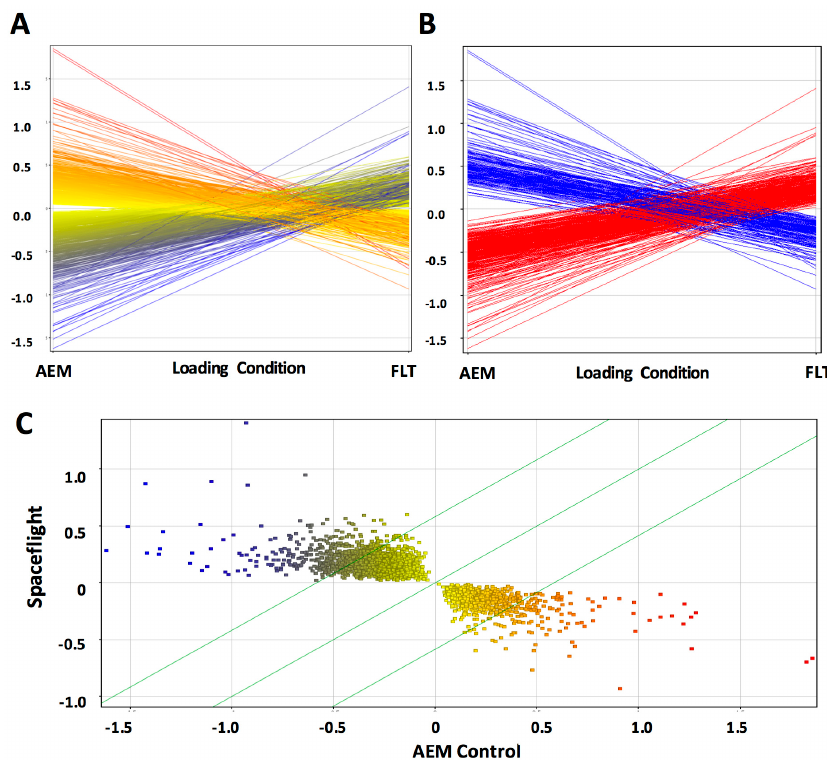
Figure 4. Hepatic gene expression is significantly altered by exposure to the space environment. Profile ( A ) and scatter ( C ) plots of all significantly regulated genes ( p ( corr ) < 0.05), and ( B ) profile plots of biologically significant genes with differential regulation FC +/ − 1.5. Red lines ( B ) and points ( C ) indicate significantly upregulated genes in AEM mice, whilst blue indicate significantly upregulated genes in FLT. Yellow indicates genes that are statistically but not biologically significant.